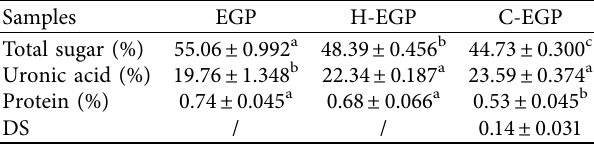
Table 1: Chemical composition of EGP, H-EGP, and C-EGP. Samples